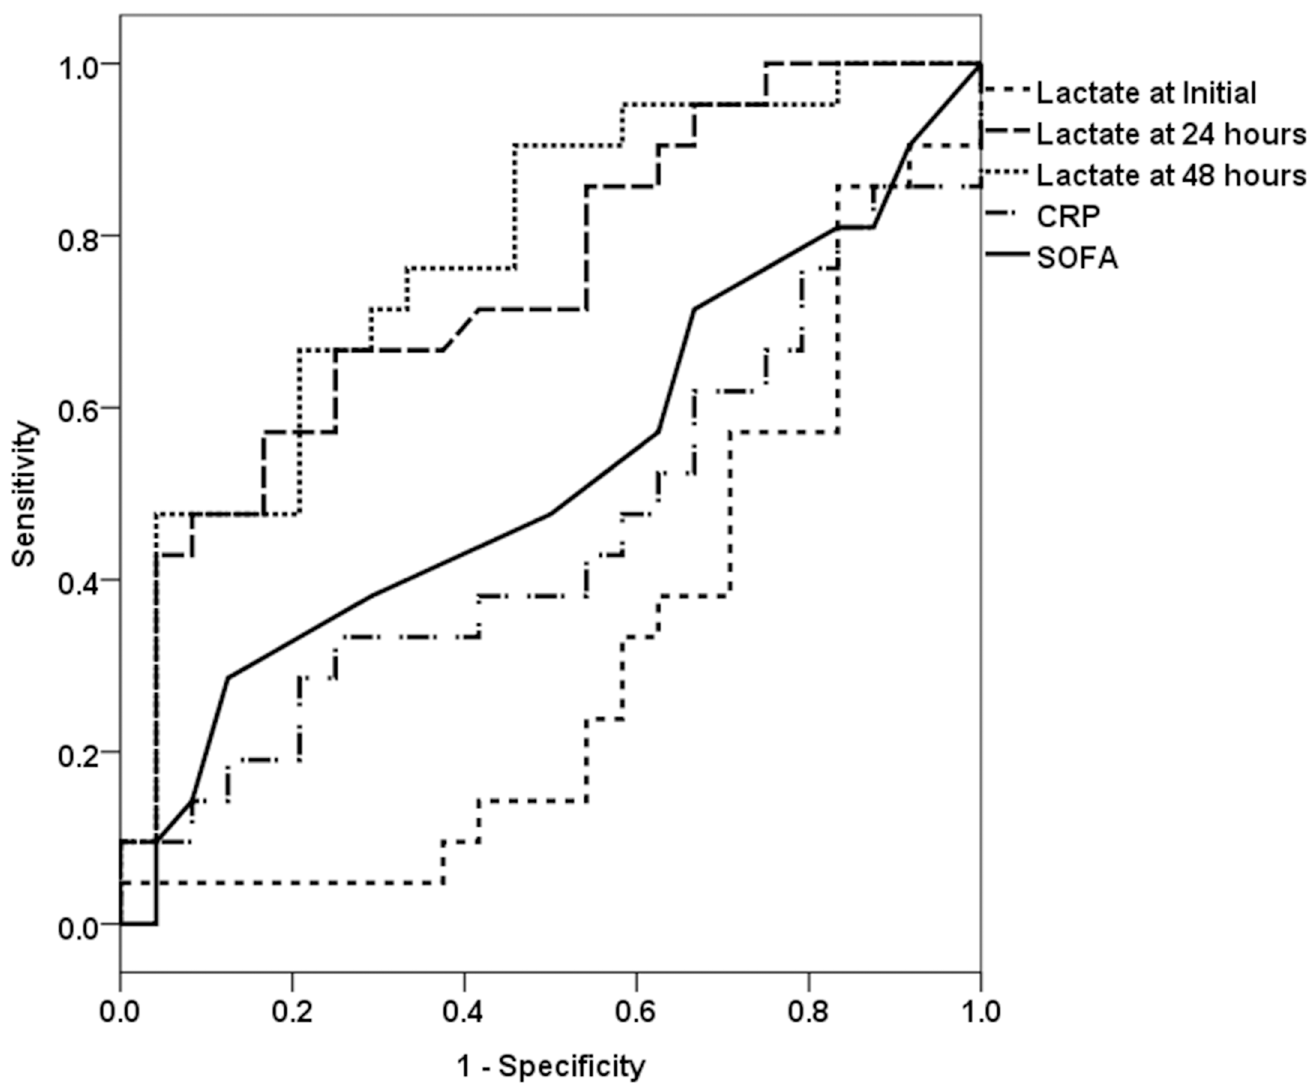
Fig 2. Receiver operating characteristic curves for lactate levels predicting 7-day